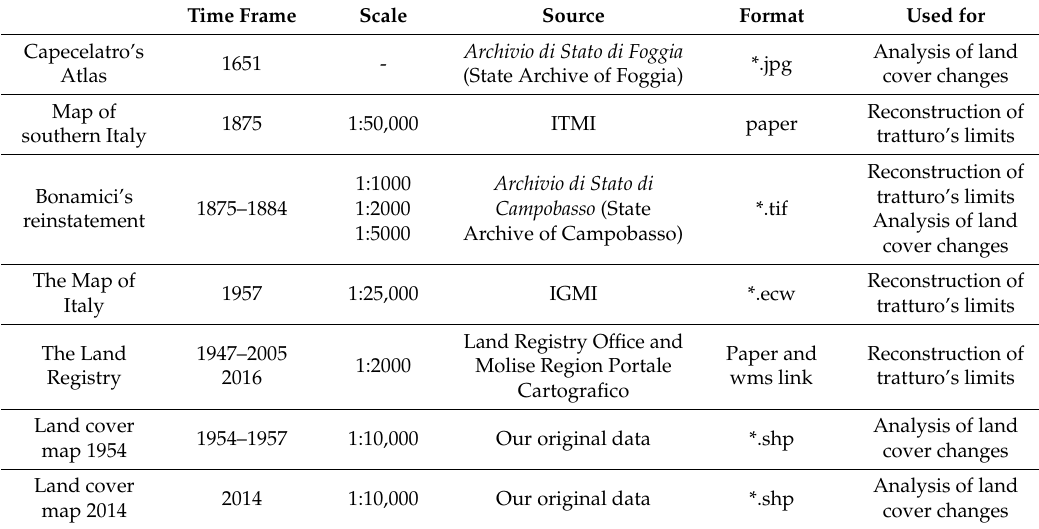
Table 2. List of the maps used in this study. Source Format Used